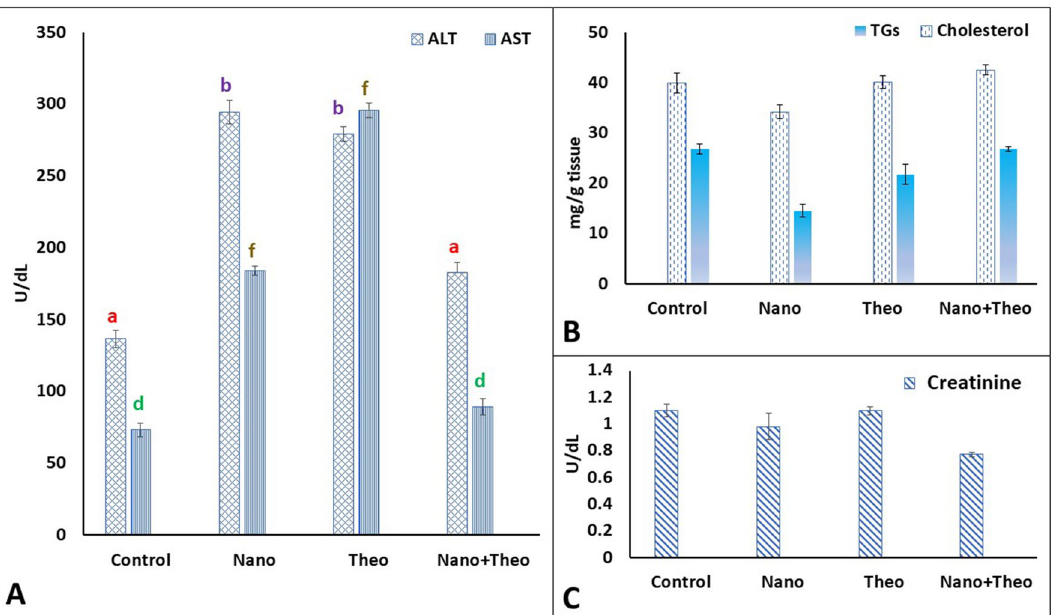
Figure 7. The effect of Nile Tilapia fish scale-based collagen nanoparticles and theophylline on aspartate aminotransferase (AST) and alanine aminotransferase (ALT) levels ( A ), cholesterol and triglycerides levels ( B ), and creatinine levels ( C ) in serum. Letters a , b , d , and f denote statistically significant difference between groups. All treatment groups had no significant effect on the levels of triglycerides, cholesterol, and creatinine. ALT, Alanine Aminotransferase; AST, Aspartate Aminotransferase; Nano = Nile Tilapia fish scale-based collagen nanoparticles; Theo = Theophylline; TGs,